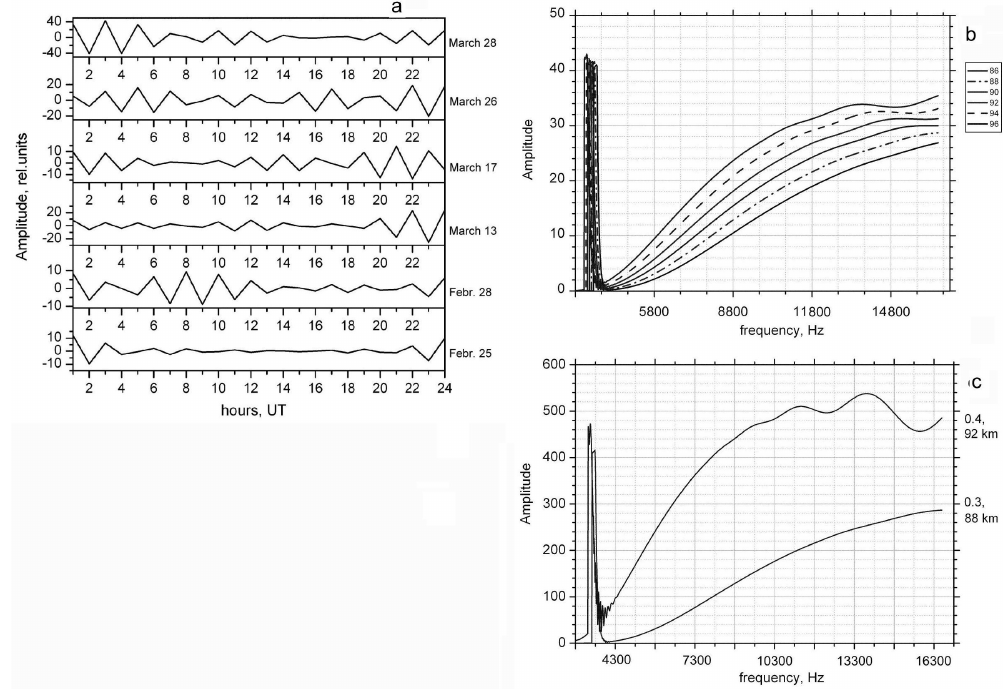
Fig. 6. (a) The variations of the amplitude of atmospherics from the filtered data with f > 0 . 4h − 1 ; the results of calculations of the signal spectra after passing the distance of 4000km at night ( b the height of the E-layer was given in the range of 88–94km, c complex change in the ionospheric parameter β and the height of the